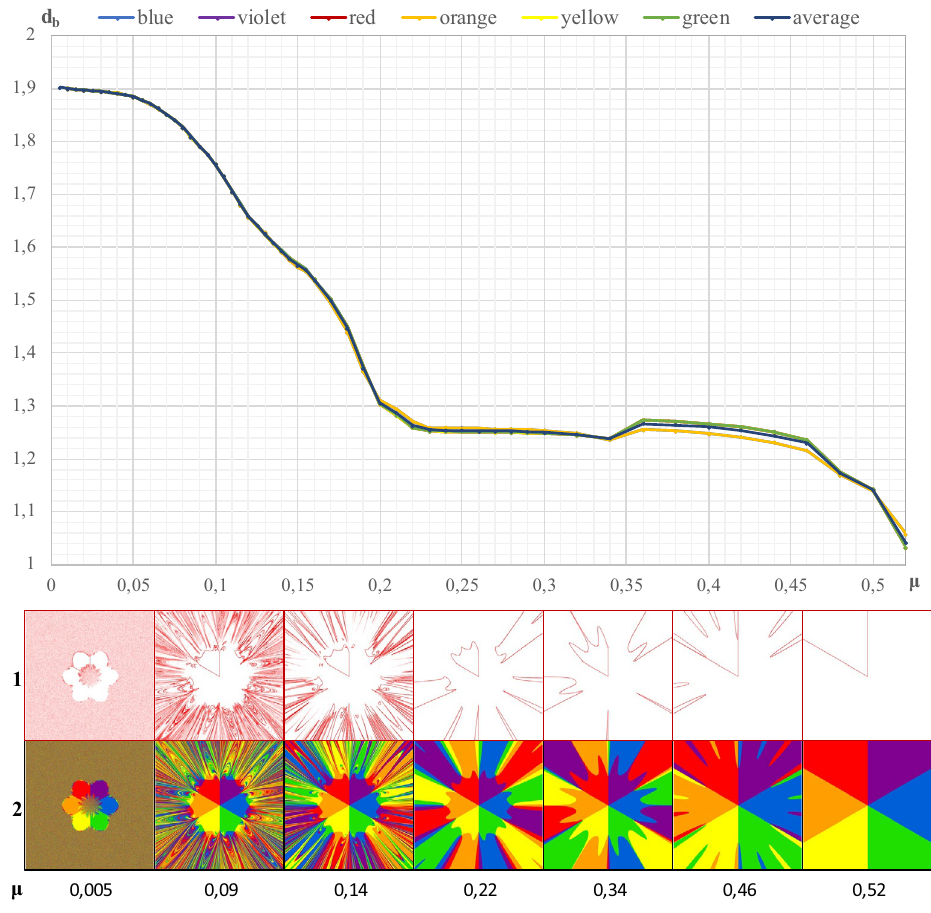
Figure 4. The box dimension of the edges of the attraction basins depending on the μ coefficient (separately for each attractor). Legend: 1–boundaries of single attraction basins, 2–entire